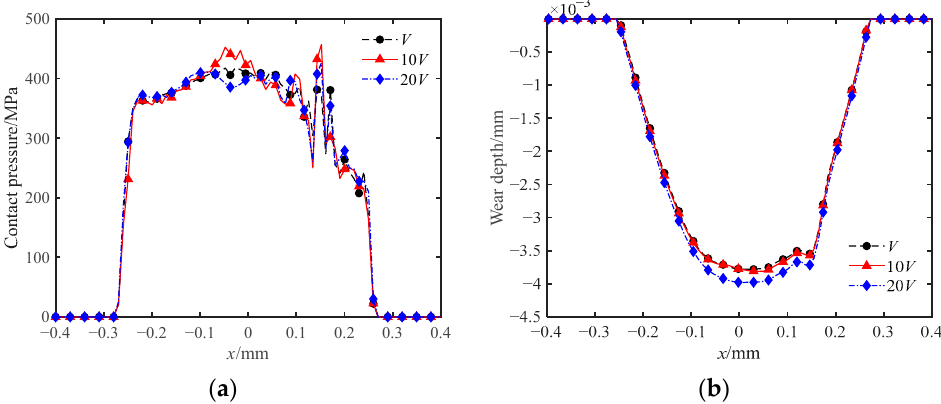
Figure 11. Variation pattern of contact pressure and wear depth with fretting speed. ( a ) Contact pressure; ( b ) Wear depth.